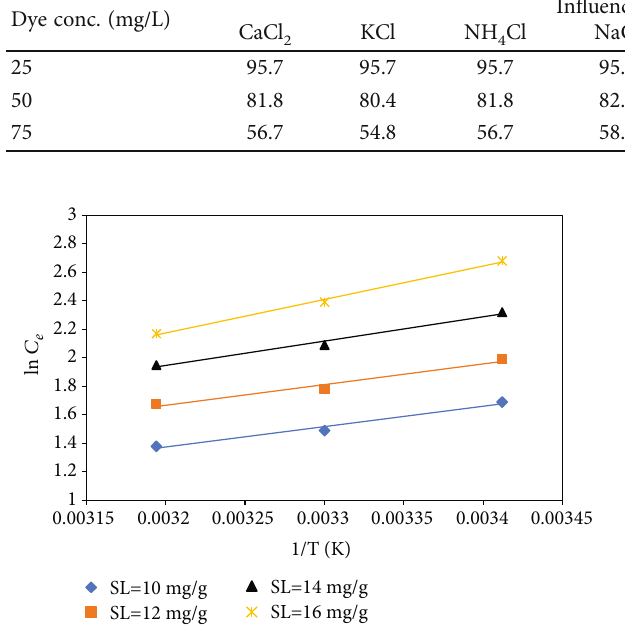
Þ vs. 1/ T for CV adsorption e